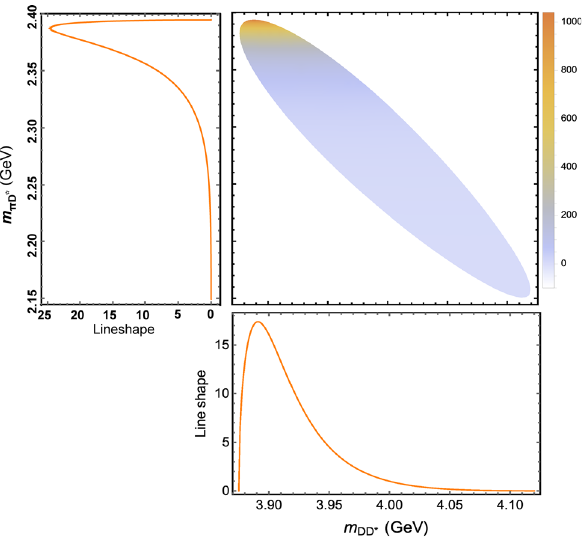
Fig. 4 A sketch diagram illustrating the reflection from D 1 ( 2420 ) in e + e − → D + ¯ D ∗ 0 π − .